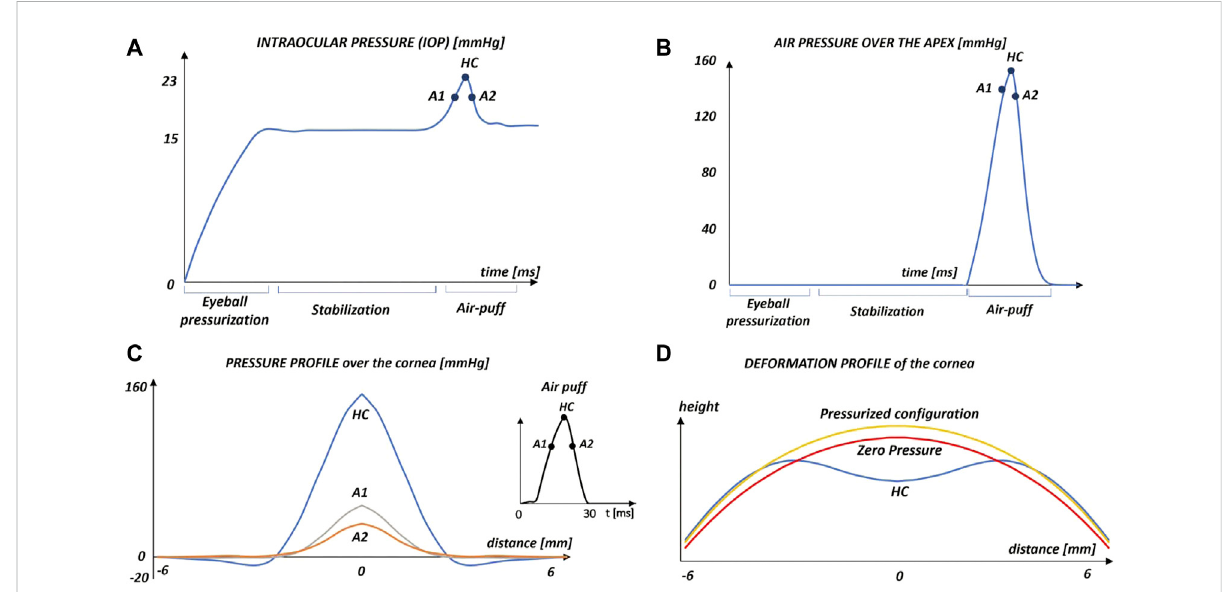
FIGURE 5 Results of the FSI simulation: (A) variation of the intraocular pressure (IOP) during the NCT simulation. The fi rst applanation point (A1), highest concavity point (HC) and second applanation point (A2) are highlighted; (B) air pressure over the corneal anterior surface during the NCT simulation. (C) pressure pro fi le overthecornea in threesigni fi cant instants ofthesimulation as afunction ofthedistancefrom theapex; (D) pro fi le of the cornea in the zero pressure con fi guration, with an intraocular pressure of 15 mmHg and at the instant of highest concavity